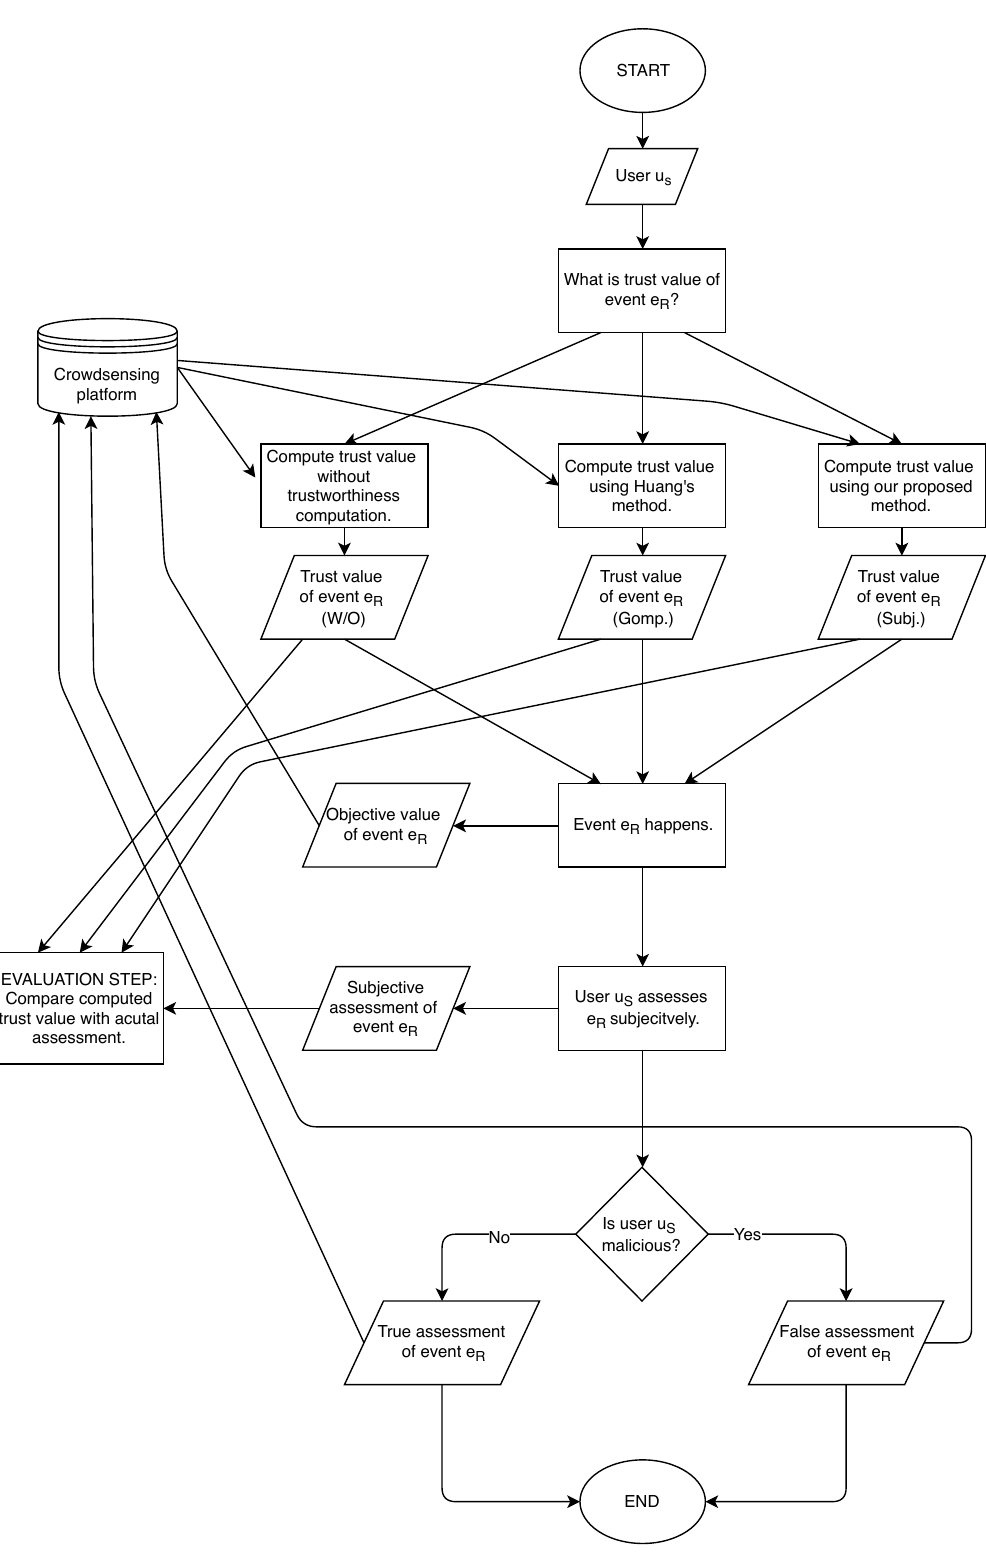
Figure 2. Algorithm chart for simulated